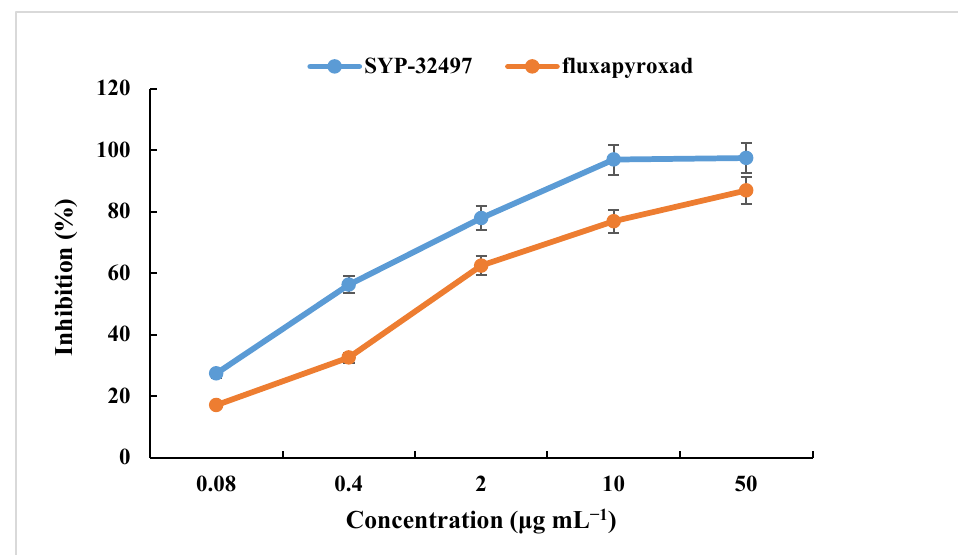
Figure 6. Enzymatic efficiencies after treatment with SYP-32497 and fluxapyroxad.